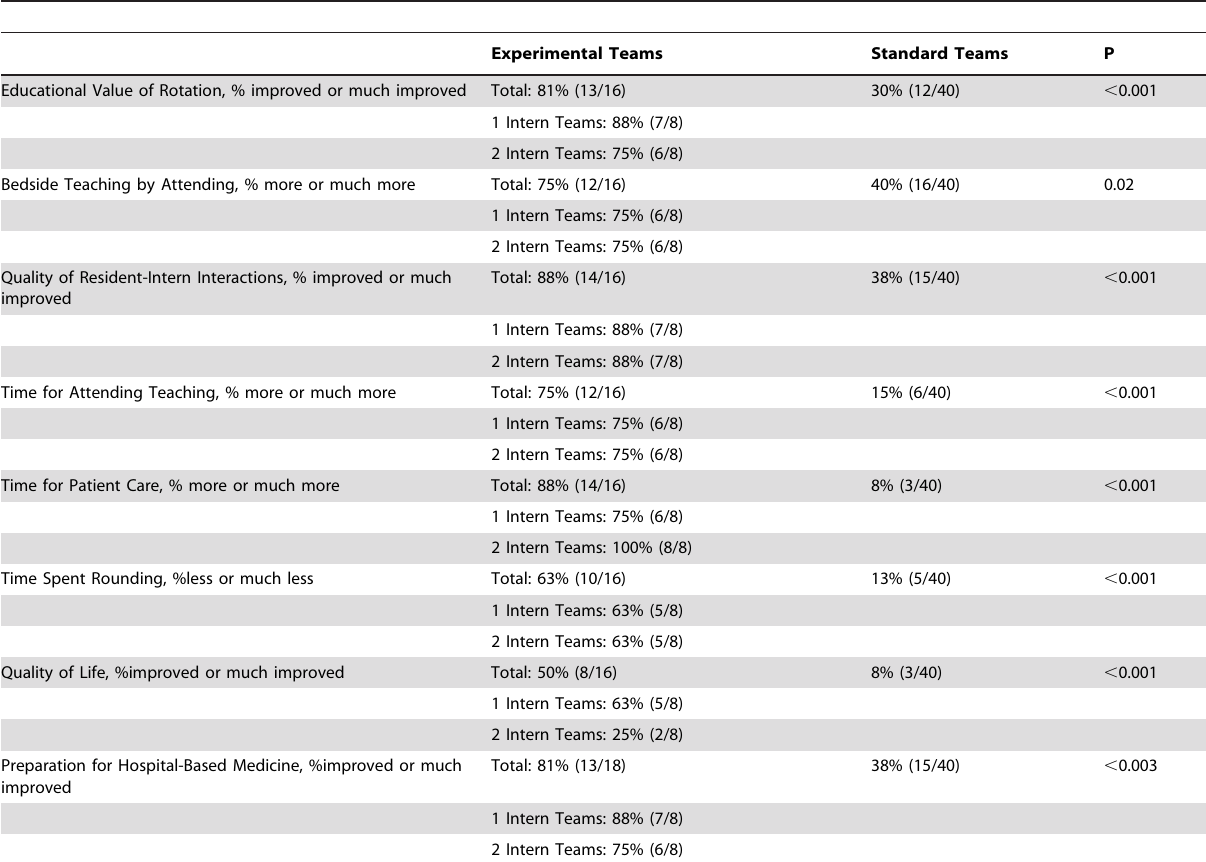
Table 4. Resident Likert Satisfaction